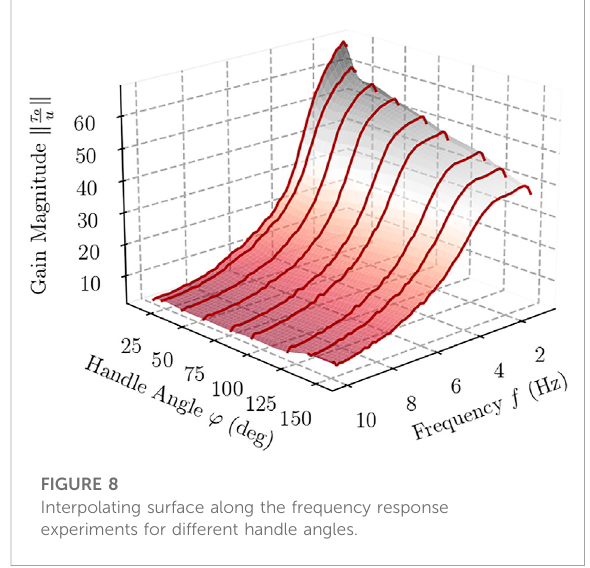
FIGURE 8 Interpolating surface along the frequency response experiments for different handle angles.